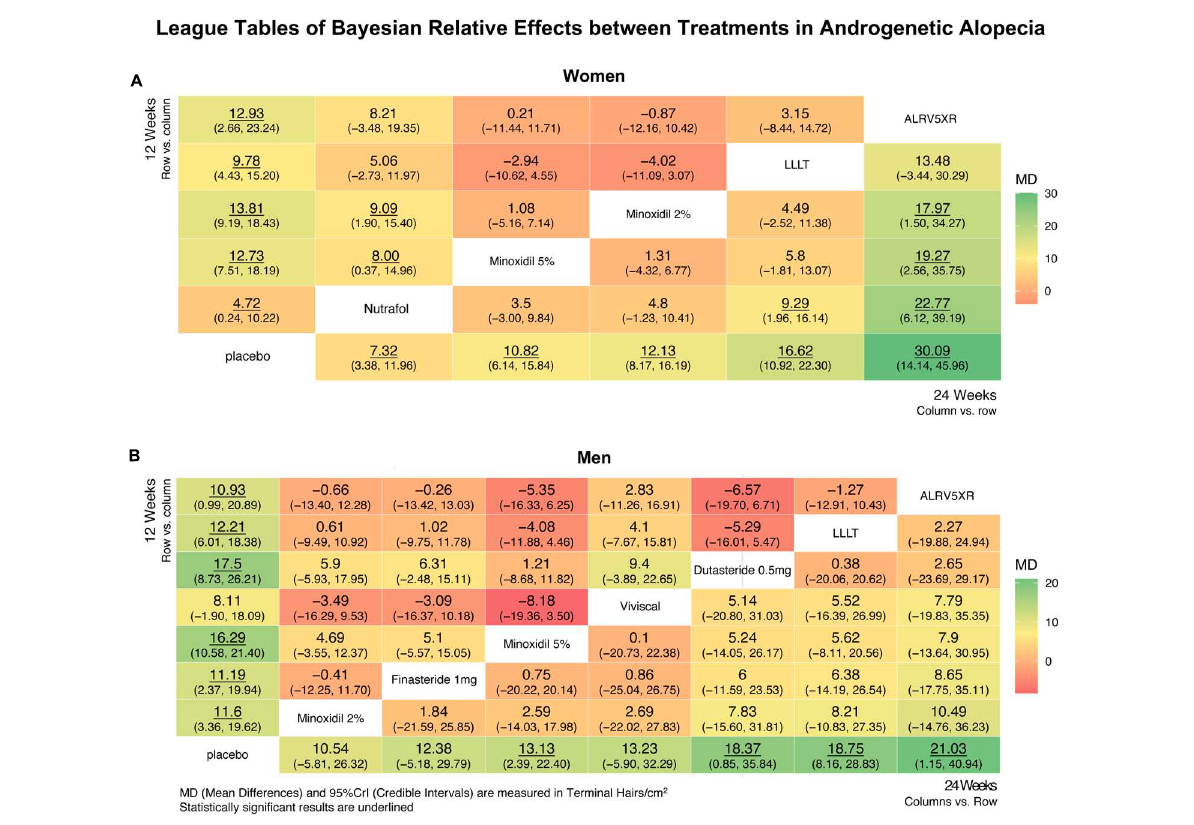
FIGURE6 League tables showing relative effects between treatments after Bayesian network meta-analysis. These results show mean differences (MD) in regrowth of terminal hairs per cm 2 (95% Credible Interval) between each treatment at 12 and 24 weeks in women (A) and men (B) , with significant differences underlined. League tables are arranged with 24 week results in the lower right diagonal and 12 week results in the top-left diagonal. Twenty four week results are treatment column vs. row, and are ranked in ascending order vs. Placebo from the bottom left row to bottom right. Twelve week results are treatment row vs. column. The largest positive differences are in dark green, and the largest negative differences are in dark red, and intermediate differences are shaded yellow